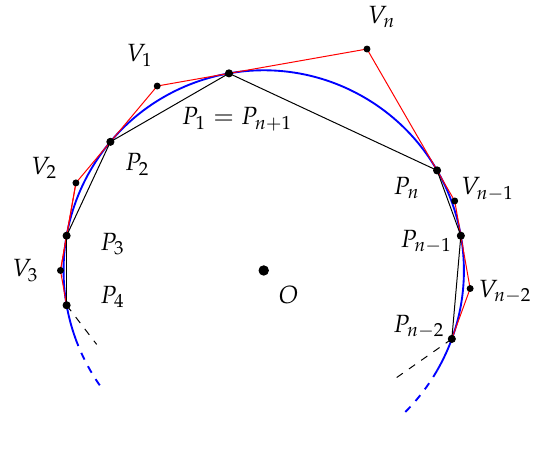
Figure 13. Inscribed and circumscribed polygons associated to a